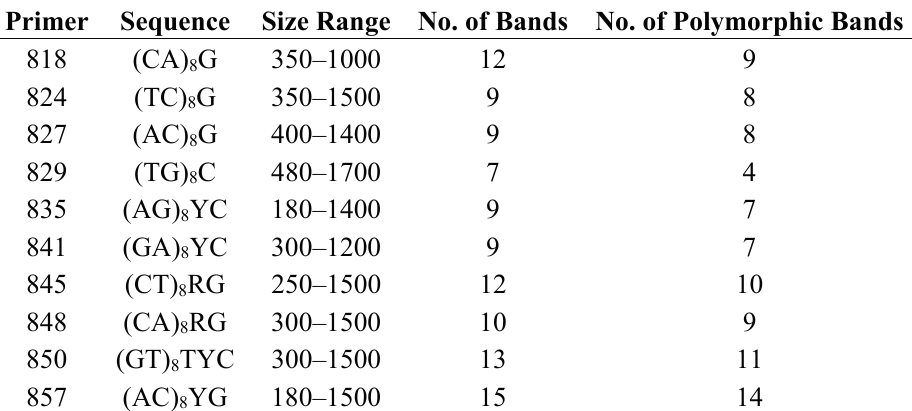
Table 1. ISSR primers used to analyze genetic diversity on populations of P. mexicana at different